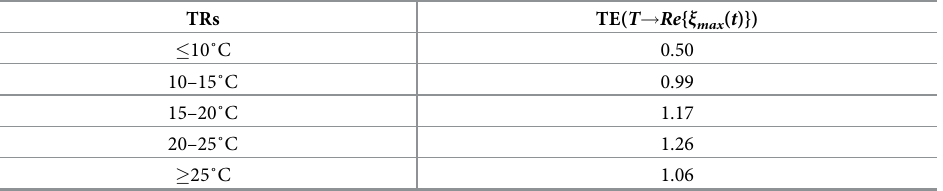
Table 2. Predicted causality between temperature and ecosystem stability for different temperature groups. The potential effect of temperature variability over time on ecosystem stability is calculate as Transfer Entropy (TE) between temperature (within TR groups) and the real part of the dominant eigenvalue (see S12A Fig for the latter). The larger TE the larger the predictive